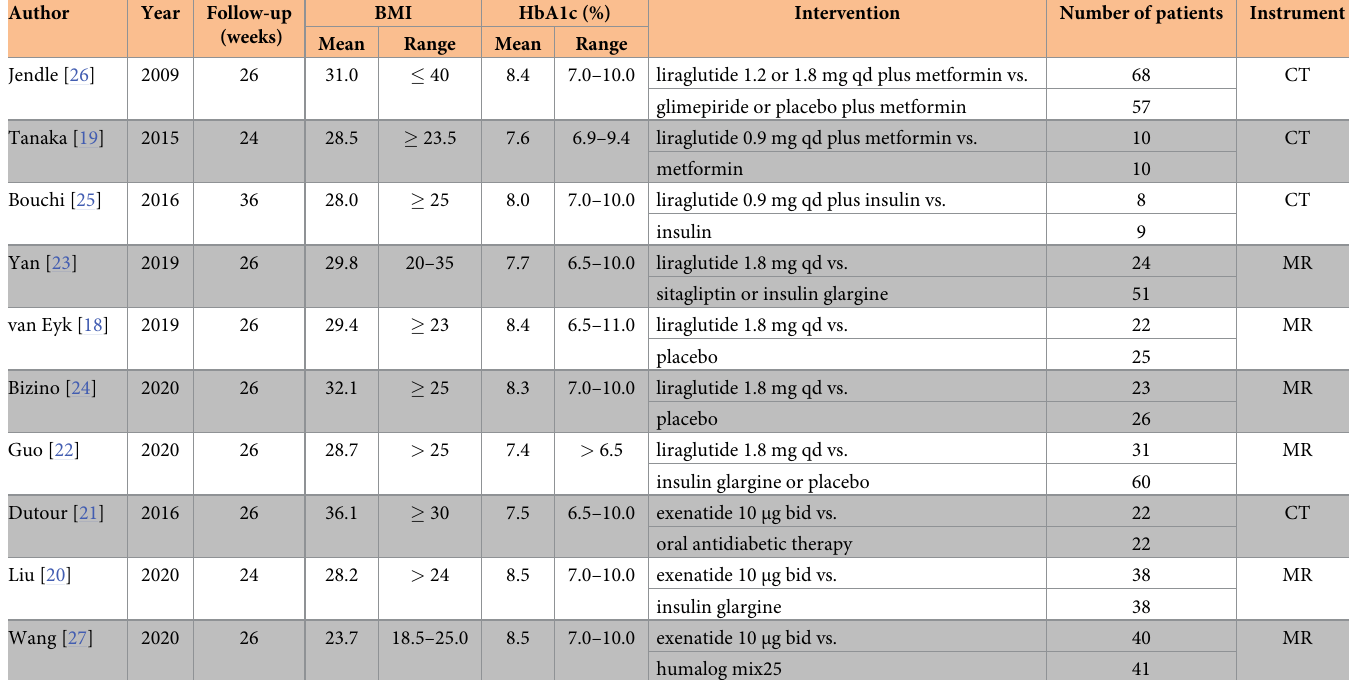
Table 1. Characteristics of the included